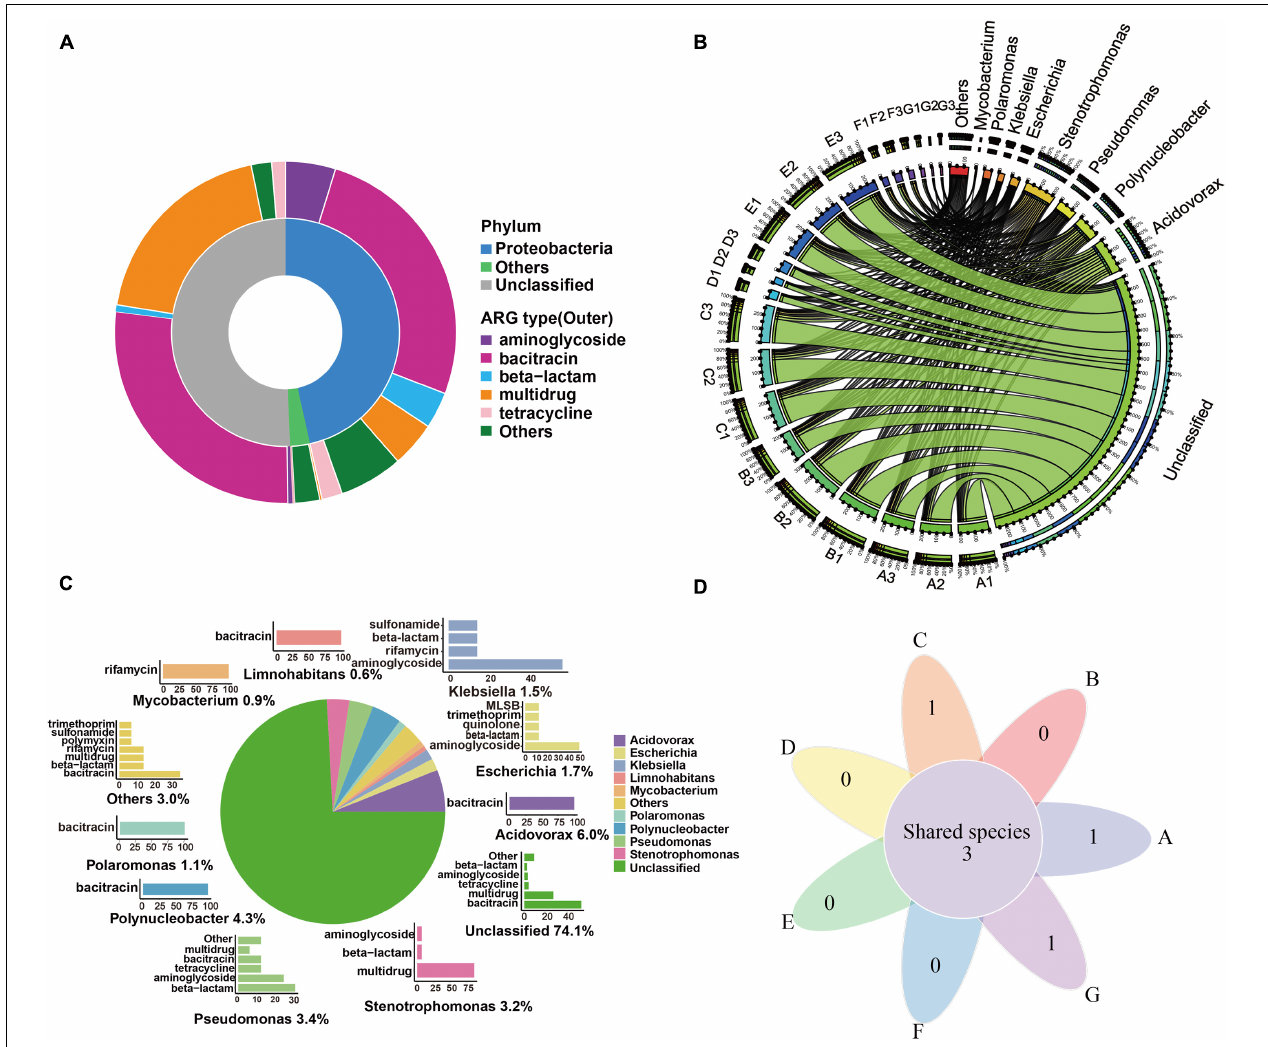
FIGURE 4 | ARG hosts analysis in the DWTS. (A) Annotation of ARG-carrying contigs at the phylum level. (B) The circle diagram shows the taxonomy and proportion of putative ARG hosts in DWTS. (C) The taxonomy of ARG-carrying contigs (in the genus level) and the percentages of ARG types these contigs carried. a: Pie chart shows the taxonomy and percentage of ARG-carrying contigs. For example, Acidovorax (6.0%) denotes that 6.0% of ARG-carrying contigs were annotated as Acidovorax . b: Bar chart shows the percentages of ARGs types that were carried by the annotated ARG-carrying contigs. The percentage of these annotated ARG-carrying contigs was set as 100%. For example, 100% of the ARG-carrying contigs originating from Acidovorax spp. carried bacitracin resistance genes. (D) Venn diagrams showing the number of shared species that carried ARG subtypes in DWTS bulk water and sand biofilm. A1–A3: raw water;